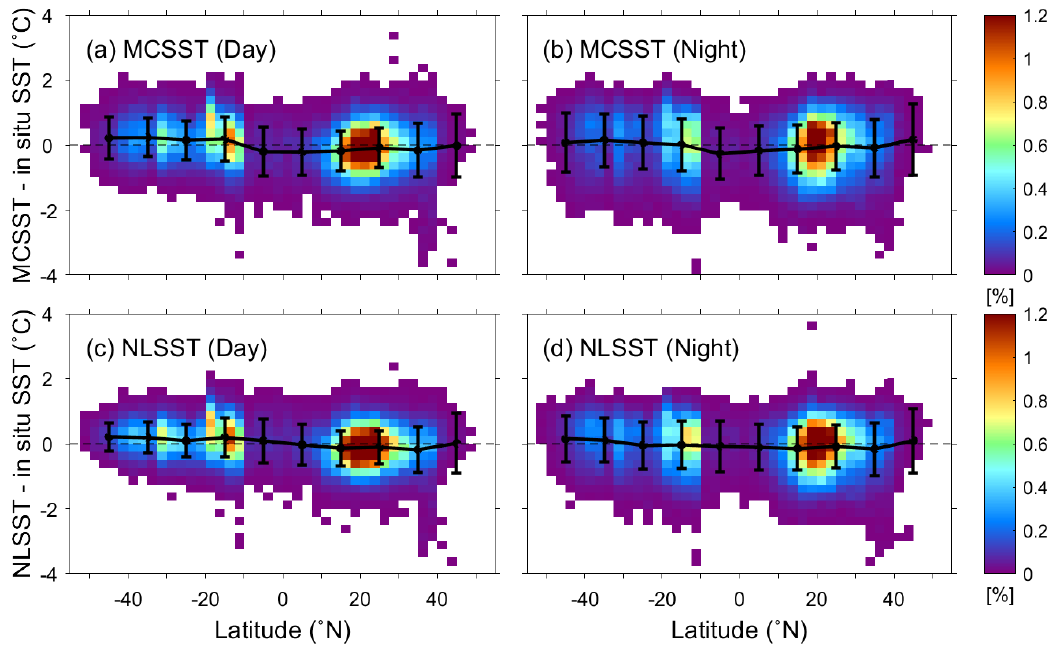
Figure 9. Distributions of MCSST errors during the ( a ) daytime and ( b ) nighttime and NLSST errors during the ( c ) daytime and ( d ) nighttime as a function of the latitude (°N).